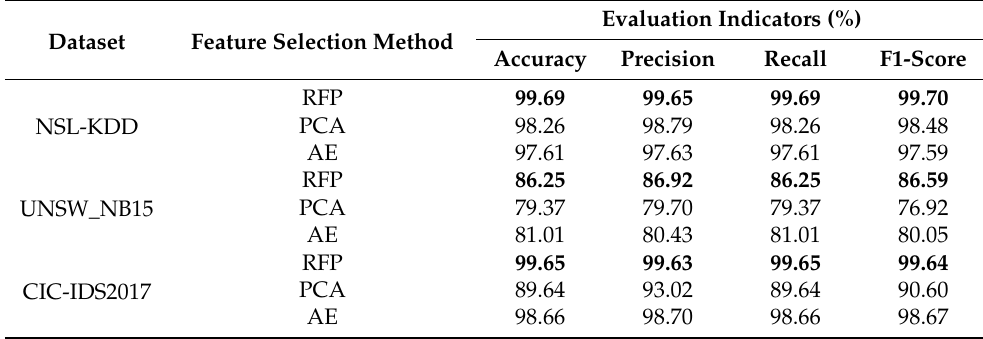
Table 8. Comparison of different feature selection